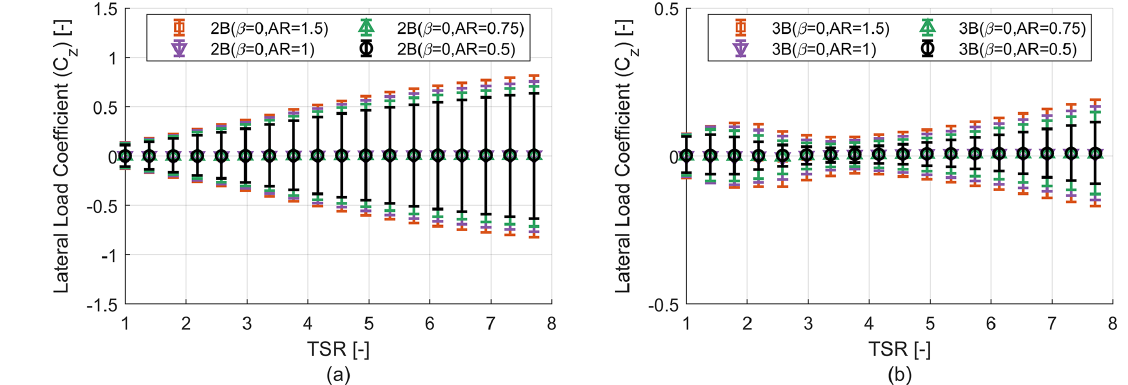
Figure 21. Lateral load coefficient ( C z ) vs. TSR for different aspect ratio (AR)